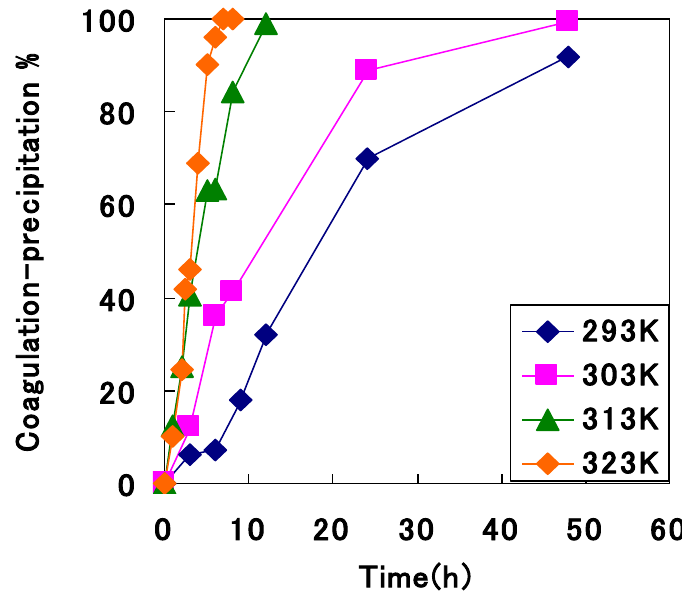
Figure 17. Percentage recovery of gold(III) by means of coagulation using persimmon extract liquor from 0.1 mol·dm −3 hydrochloric acid solution at varying temperatures [32] (with permission for reuse from The Society of Chemical Engineers of